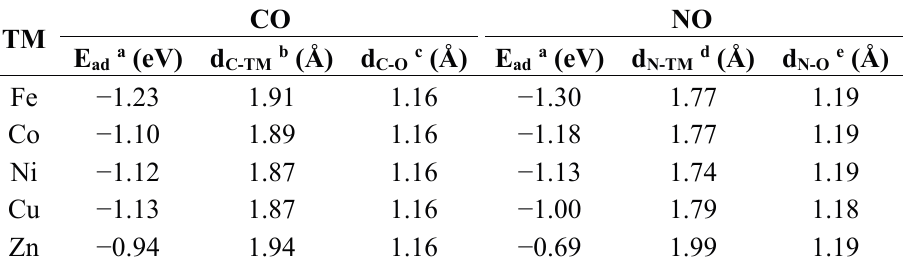
Table 3. The structural and energetic parameters for CO and NO adsorption on TM-MG composites.